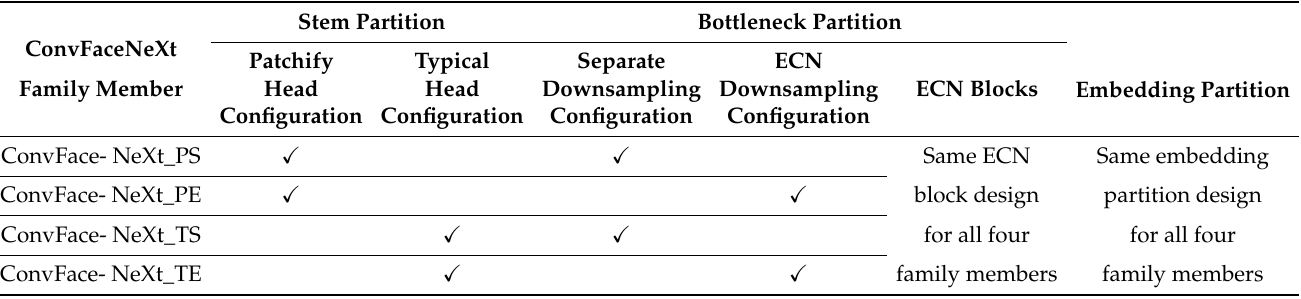
Table 2. The general architecture design for each ConvFaceNeXt family